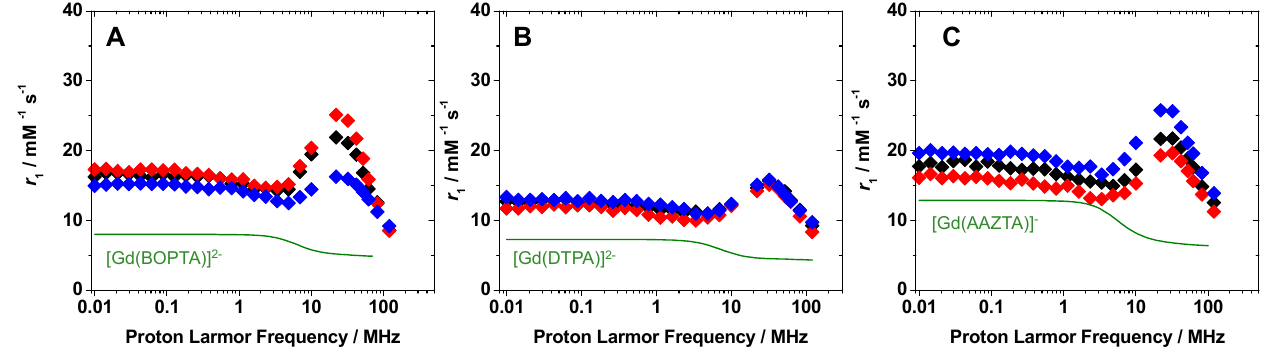
Figure 3. 1 H NMRD profiles of Fmoc-K2+[Gd(BOPTA)] 2 − ( A ), Fmoc-K2+[Gd(DTPA)] 2 − ( B ) and Fmoc-K2+[Gd(AAZTA)] − ( C ) at 283 (blue), 298 (black) and 310 K (red). The profiles of the corresponding chelates in aqueous solution are also reported as solid lines.